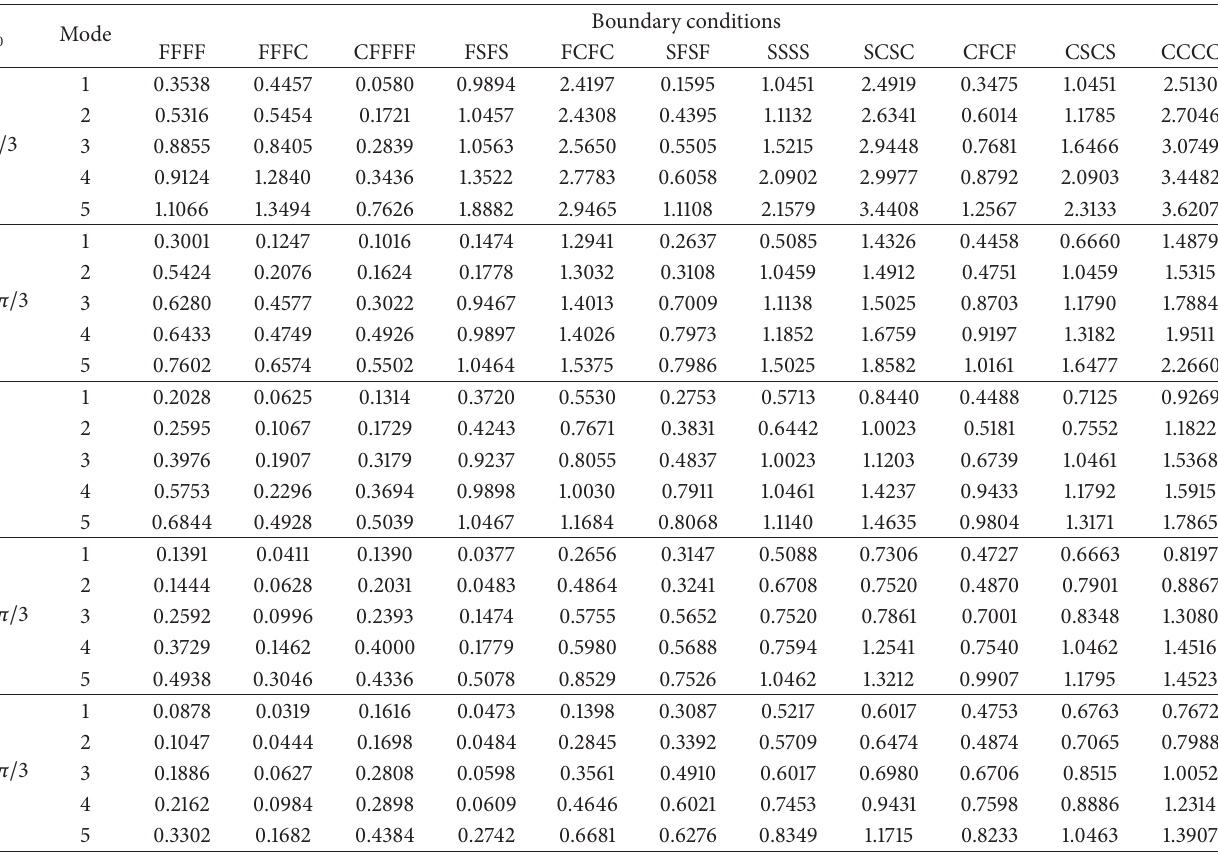
Table 6: The first five frequency parameters Ω = 𝜔𝑅√𝜌/𝐺 of an open isotropic cylindrical shell with various boundary conditions and included angles ( 𝑅 = 1 m, 𝐿/𝑅 = 3 , ℎ/𝑅 = 0.3 , 𝐸 = 210 GPa, and 𝜇 = 0.3 ).